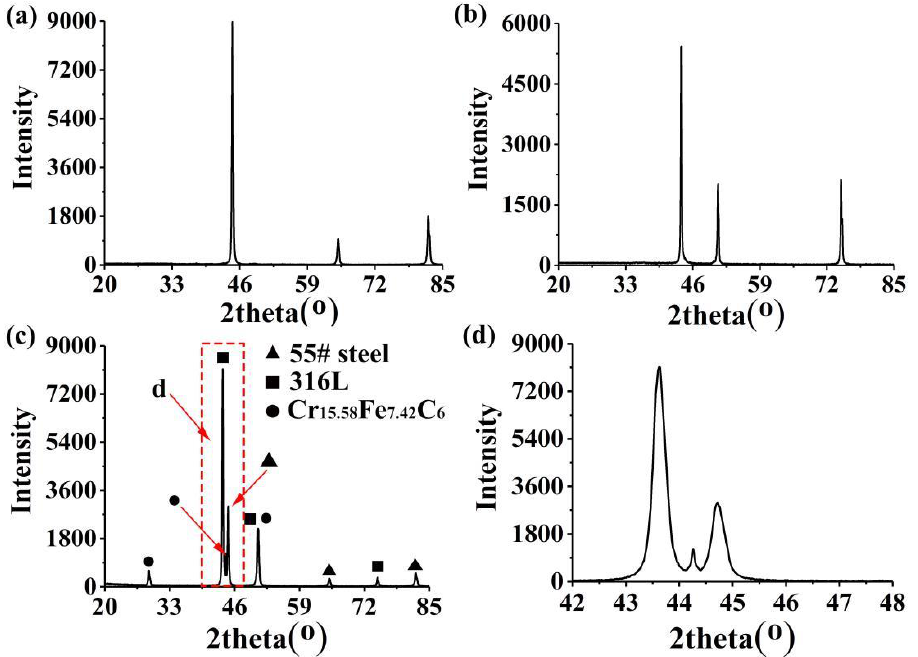
Figure 6. XRD results: ( a ) 55# steel, ( b ) 316L stainless steel, ( c ) 55#/316L rebars, and ( d ) partial enlarged view of XRD results.